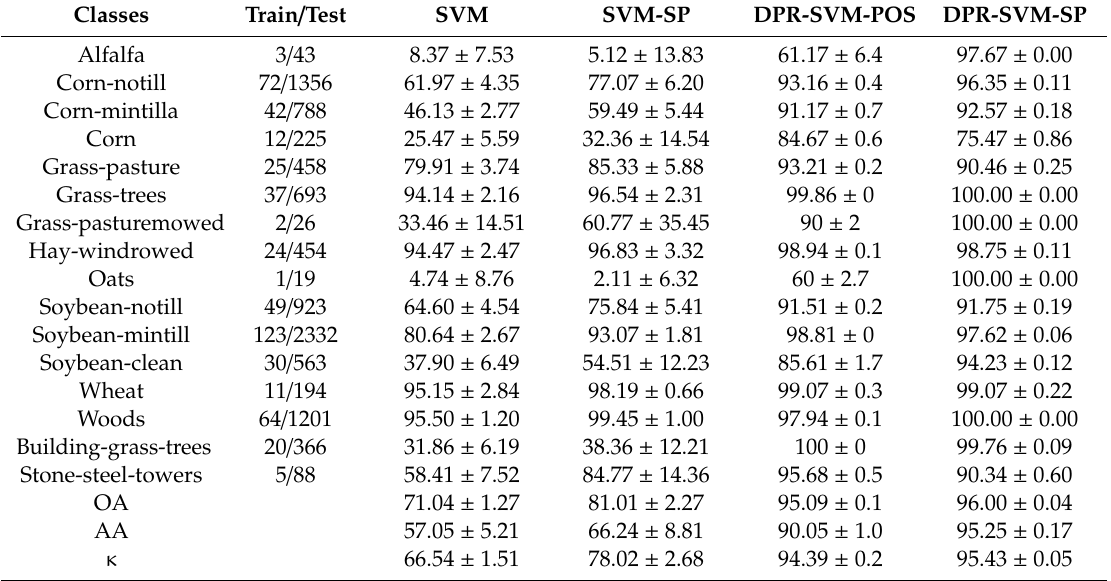
Table 2. Statistical results (mean and standard deviation in percent) of 10 independent classifications provided by SVM, SVM-SP, DPR-SVM-POS and DPR-SVM-SP on Indian Pines datasets with 5% labeled samples per class, s = 5 and β =